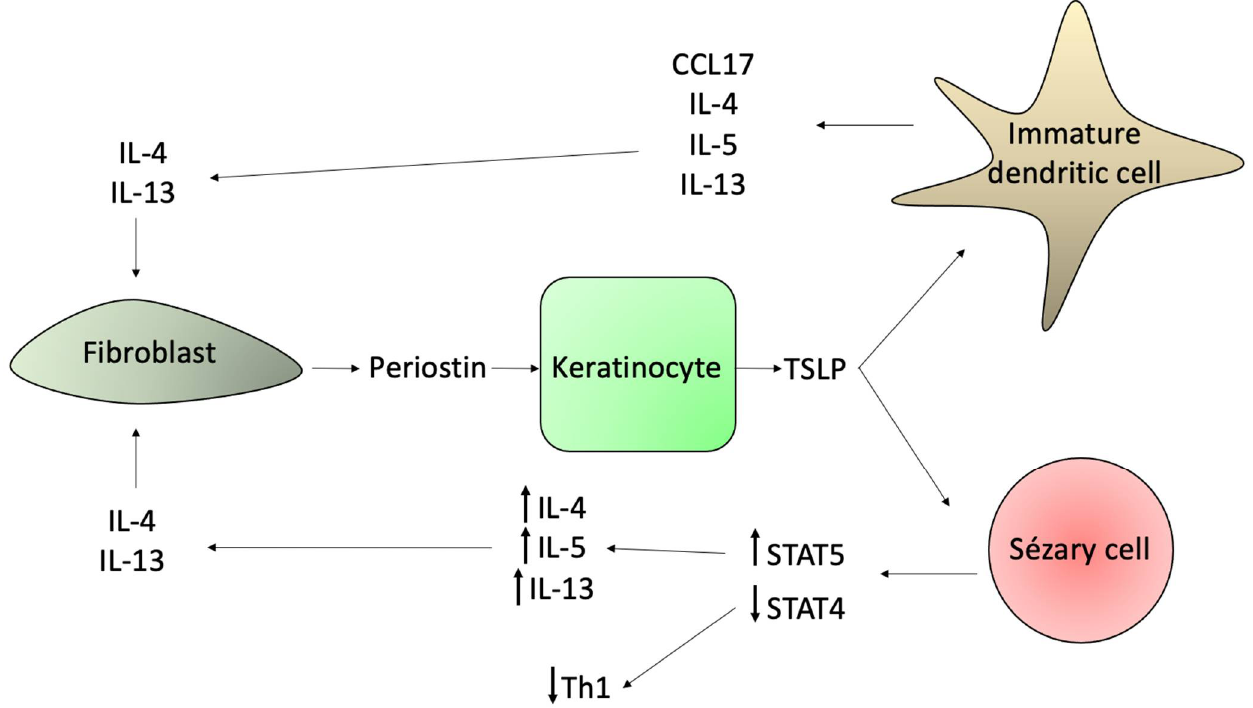
Figure 9. The role of periostin on the SS tumor microenvironment. The periostin, secreted by fibroblasts after activation by IL-4 and IL-13, stimulates TSLP production by keratinocytes. The TSLP stimulates immature DCs and Sézary cells to secrete Th2 cytokines, which will ultimately interact with fibroblasts to produce more periostin in a positive loop.